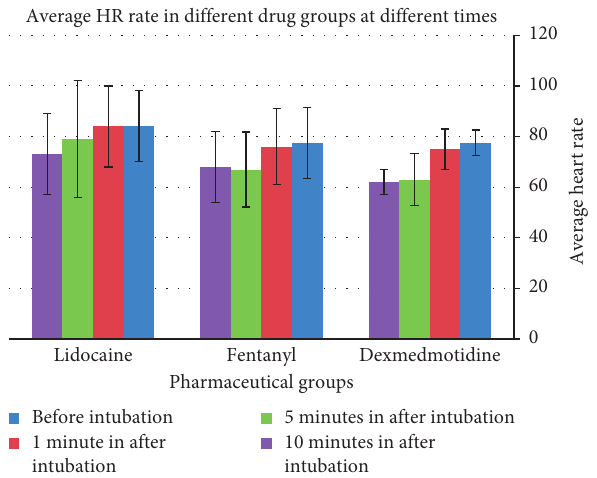
Figure 2: Comparison of HR in the 1st, 3rd, 5th, and 10th minutes after intubation with before intubation in each